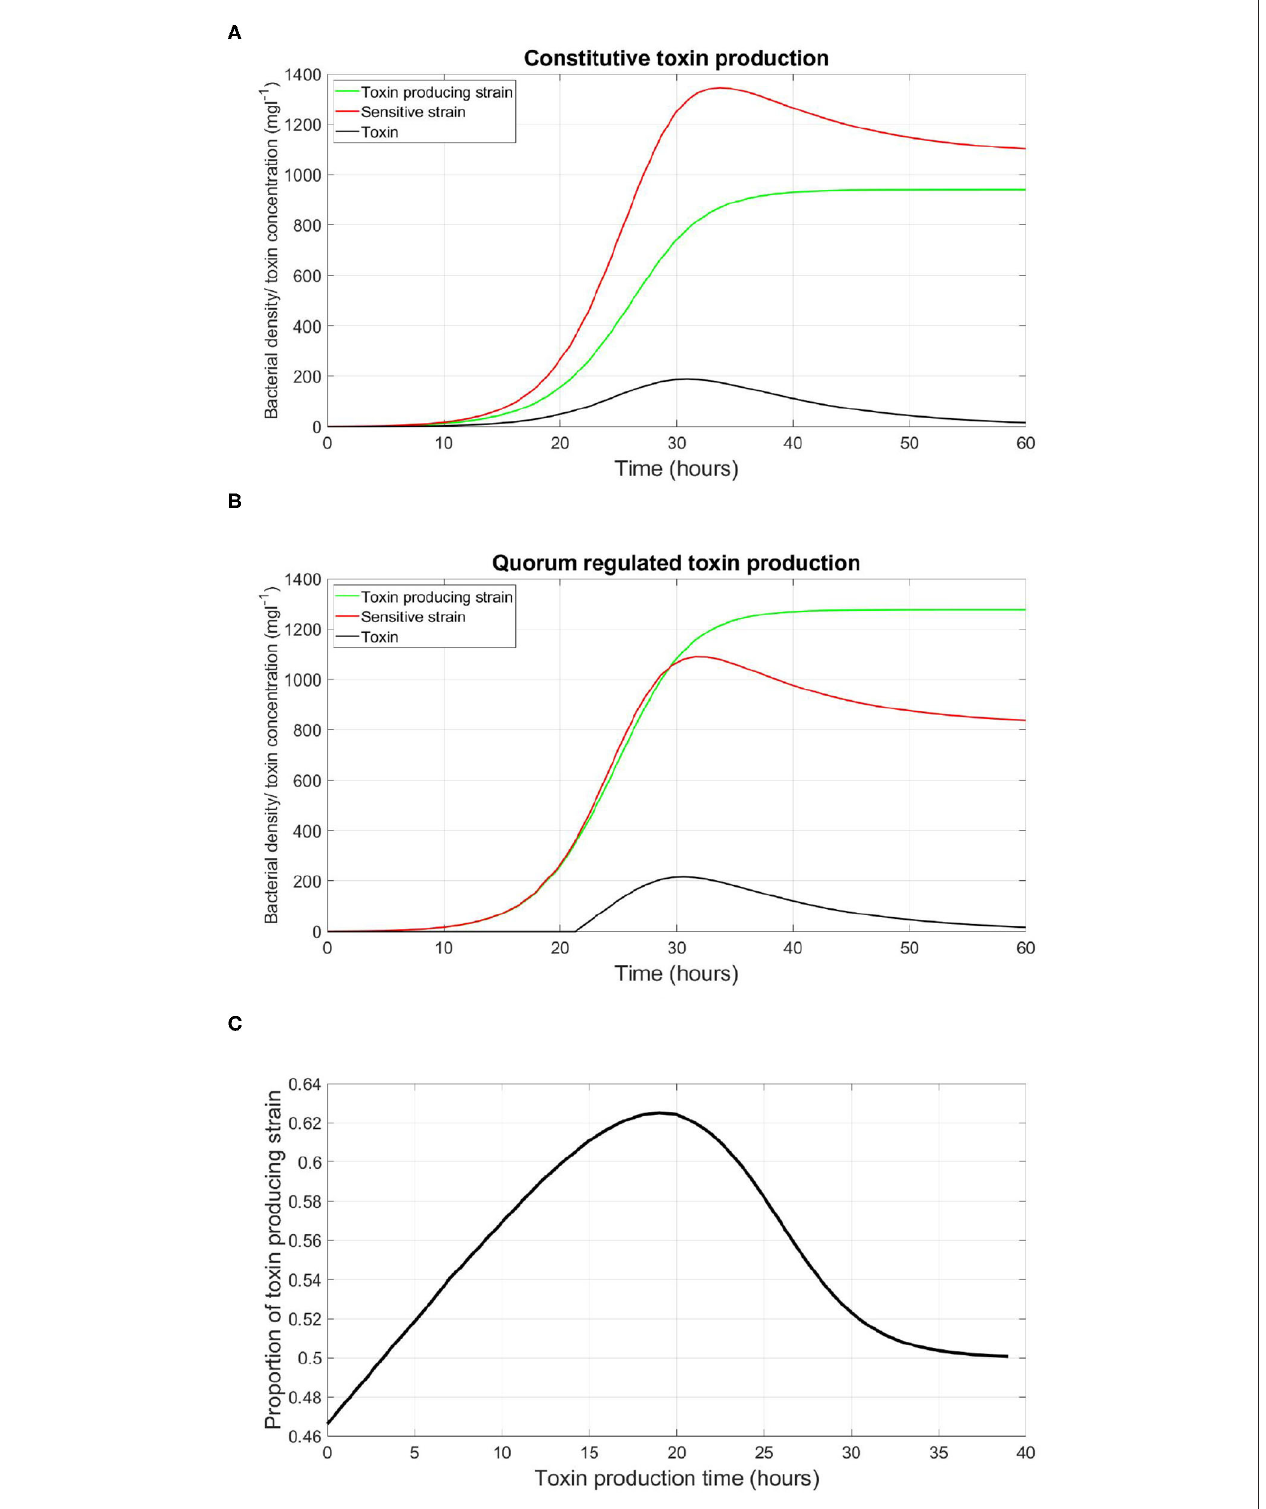
FIGURE 2 | An illustration of the role played by QS regulation of costly traits in deciding the fate of microbial conflicts. (A) The evolution of the density of the QS toxin producing strain and the sensitive strain in well-mixed environment, where toxin production is constitutive. (B) The evolution of the density of the QS toxin producing strain and the sensitive strain in well-mixed environment, where toxin production is regulated by QS to start at a high bacterial density. (C) The relationship between the time at which toxin production starts by the QS toxin producing strain and its fitness when competing with the sensitive strain, where the fitness of a given strain is defined as the proportion of the said strain in the population by the end of the simulation. Time zero corresponds to constitutive toxin production.